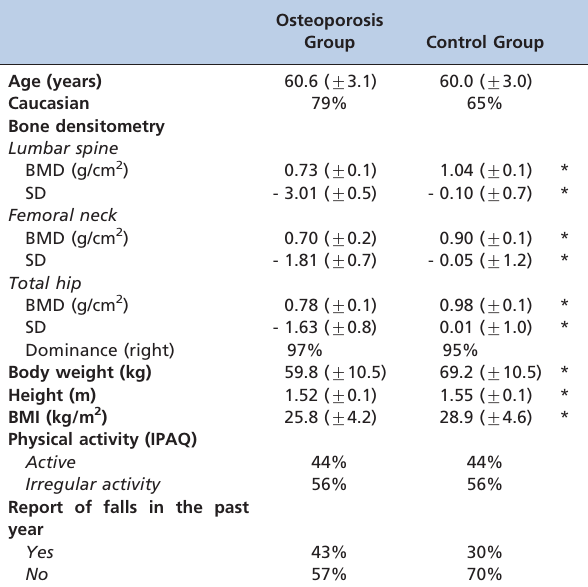
Table 1 - Baseline characteristics of the